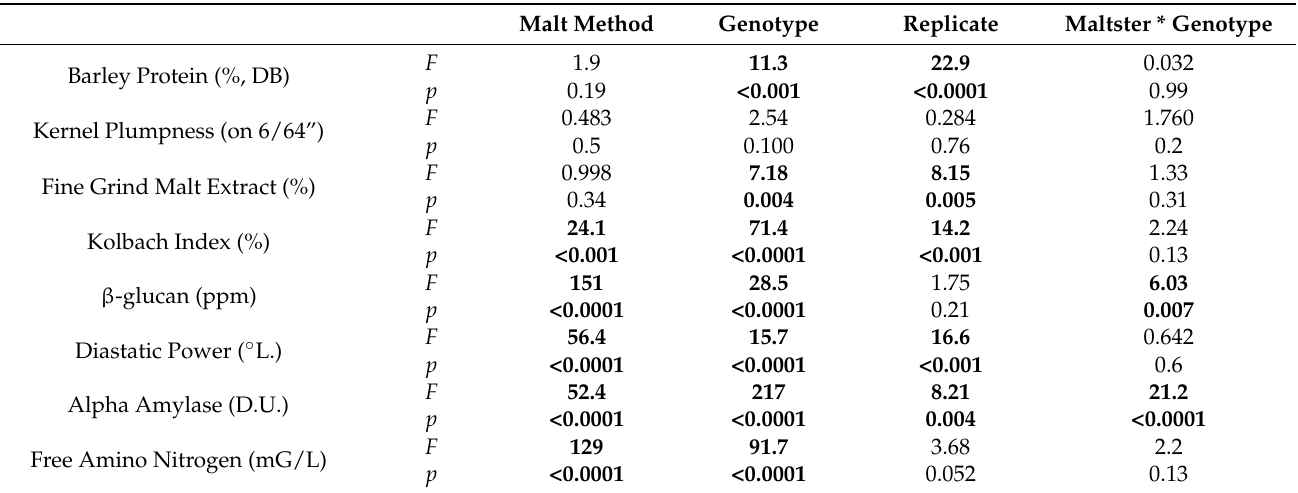
Table 2. Three-way analysis of variance of malt method (modified or uniform), genotype (Copeland, 117.17, 120.14, 120.17), and replicate (1, 2, 3) and the interaction between malt method and genotype. F -values ( F ) and p -values ( p ) are reported for each malt quality traits listed. p -values less than alpha 0.05 and the respective F -value are bolded. Malt Method Genotype Replicate Maltster *